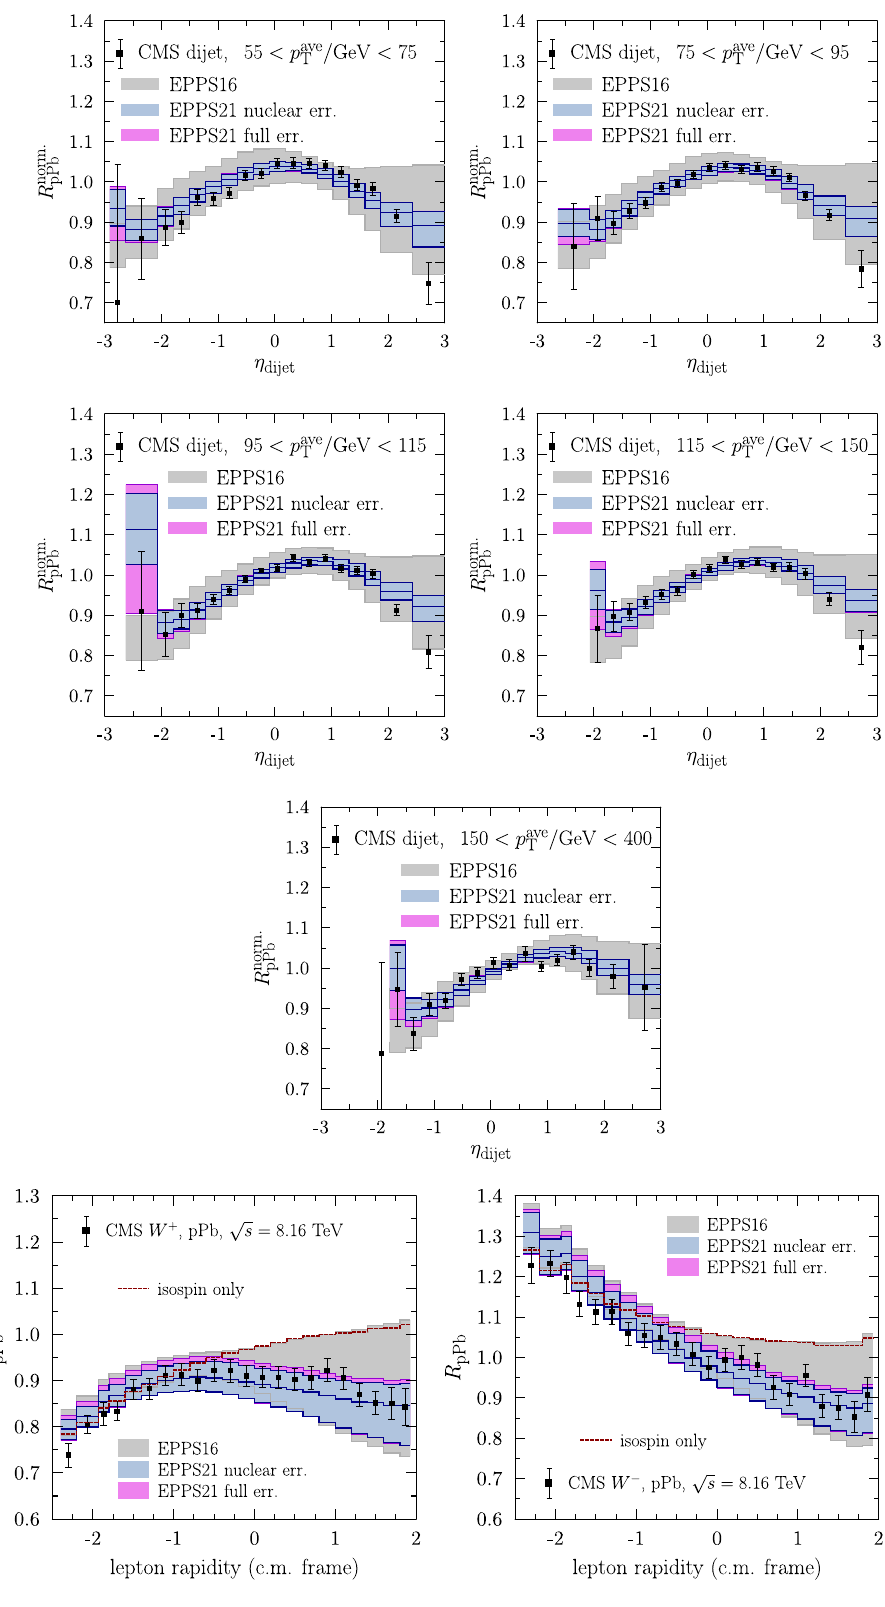
Fig. 15 The CMS dijet data [3] compared with the EPPS21 analysis. The solid blue lines show our central results, inner blue bands the nuclear uncertainties, and the purple bands the total uncertainty. The grey bands correspond to the EPPS16 results